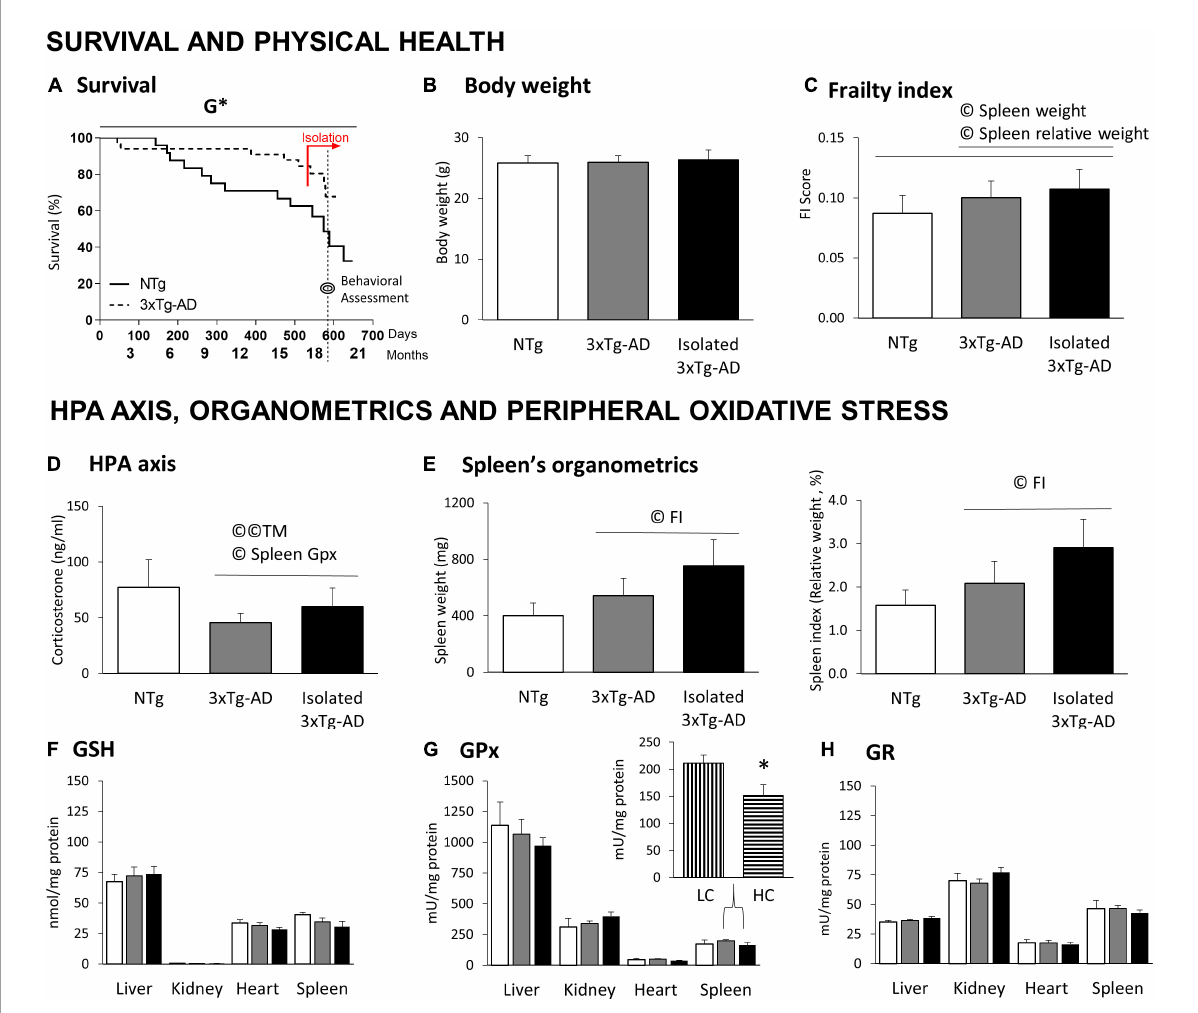
FIGURE3 Survival, physical health, HPA axis, and peripheral oxidative stress in 18-month-old 3xTg-AD females compared to NTg females with normal aging. (A) Survival; (B) body weight; (C) frailty index scores; (D) HPA axis measured by Corticosterone levels; (E) organometrics of spleen: weight and spleen index (relative weight, % vs. body weight); Oxidative Stress of liver, kidney, heart, and spleen: (F) GSH levels; (G) GPx enzymatic activity and (H) GR enzymatic activity. Results are expressed as the mean ± SEM. HC (high corticosterone levels), LC (low corticosterone levels). Statistics: Kaplan-Meier and Log-Rank test; G, genotype effect, G* p < 0.05. Student t -test, * p < 0.05 vs. LC counterparts. Pearson’s correlation analysis, © p < 0.05; ©© p < 0.01; TM, T-maze test; FI, frailty